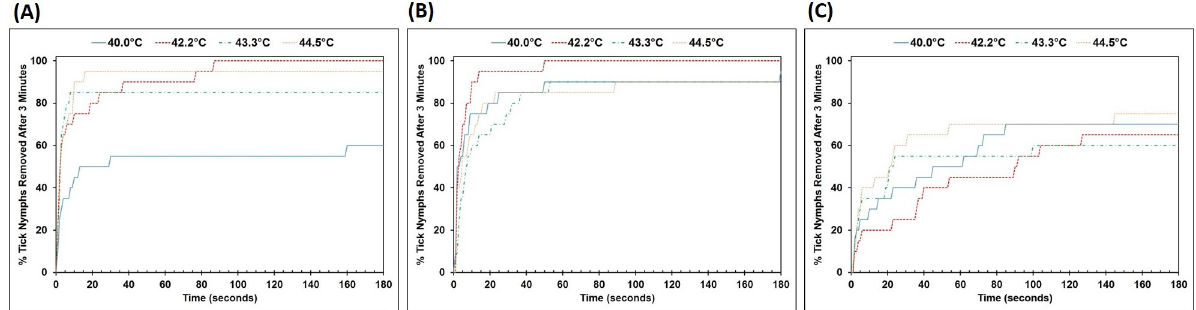
Fig 2. Cumulative frequency graphs of percentage of (A) Ixodes , (B) Dermacentor , and (C) Amblyomma tick nymphs removed from the surface of the silicone skin equivalent with time. Except for Ixodes nymphs at 40.0˚C which showed a lower removal percentage compared to the higher temperatures, there is no observable temperature dependence on tick nymph removal for all 3